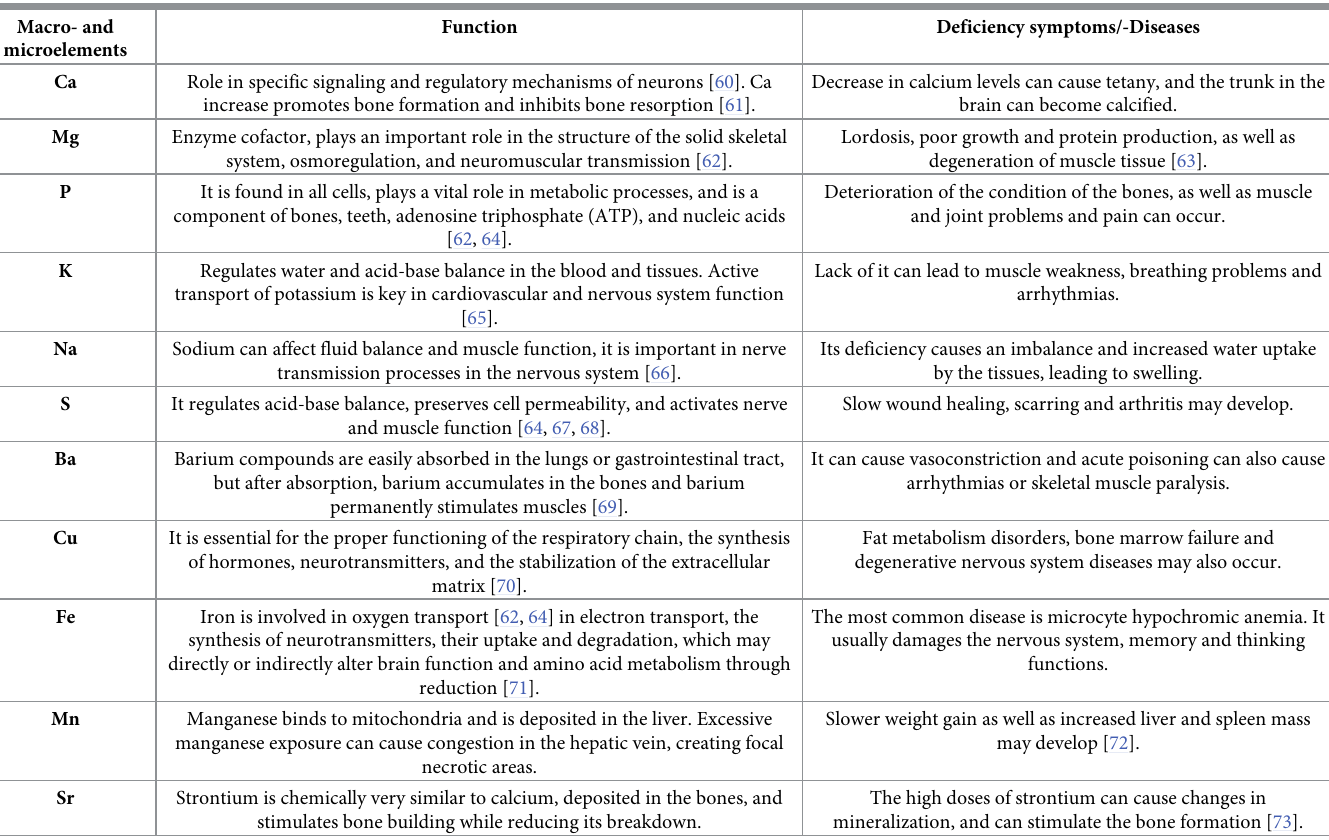
Table 1. Summary of the functions and deficiency symptoms/-diseases of the macro- and microelements used in the study. Macro- and Function Deficiency microelements